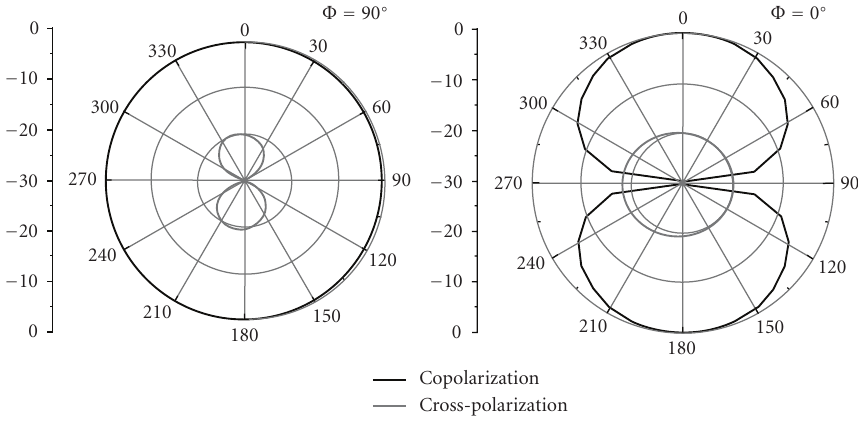
Figure 7: Simulated copolarization and cross-polarization radiation patterns.